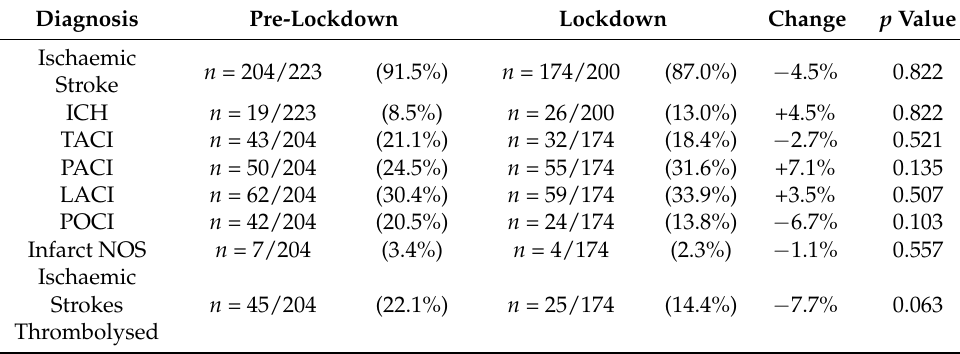
Table 2. Stroke Subtypes in the Pre-lockdown and Lockdown Cohorts. Proportion of stroke sub- types in the pre-lockdown and lockdown cohorts, with no significant differences identified. The proportion of ischaemic strokes thrombolysed was reduced in the lockdown cohort, but this was non-significant. p values were generated with Fisher’s Exact Test; values <0.05 were deemed sta- tistically significant. ICH: intracerebral haemorrhage, TACI: total anterior circulation infarct, PACI: partial anterior circulation infarct, LACI: lacunar infarct, POCI: posterior circulation infarct: NOS: not otherwise specified.